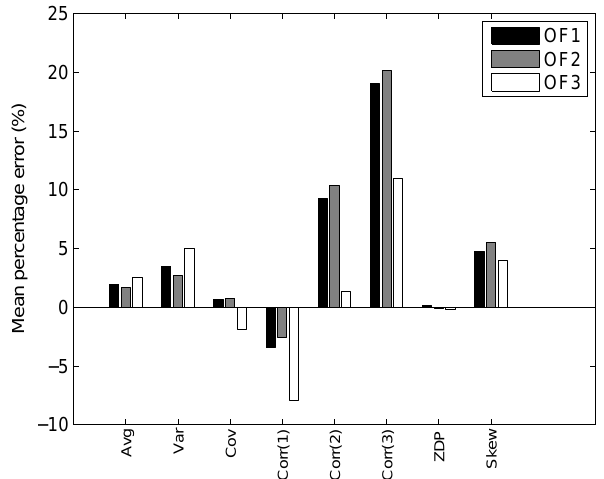
Fig. 11: Mean Absolute Percentage Error of different fits, averaged over different months and aggregation levels (10 min, 30 min, 1 h, 6 h, 12 h and 24 h) Table 8: Final parameters resulting from calibration with OF3 found by each of the optimization methods.